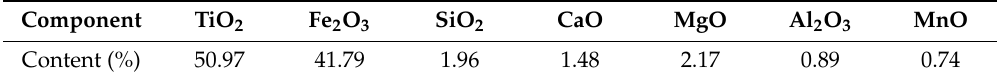
Table 1. Chemical composition of the ilmenite